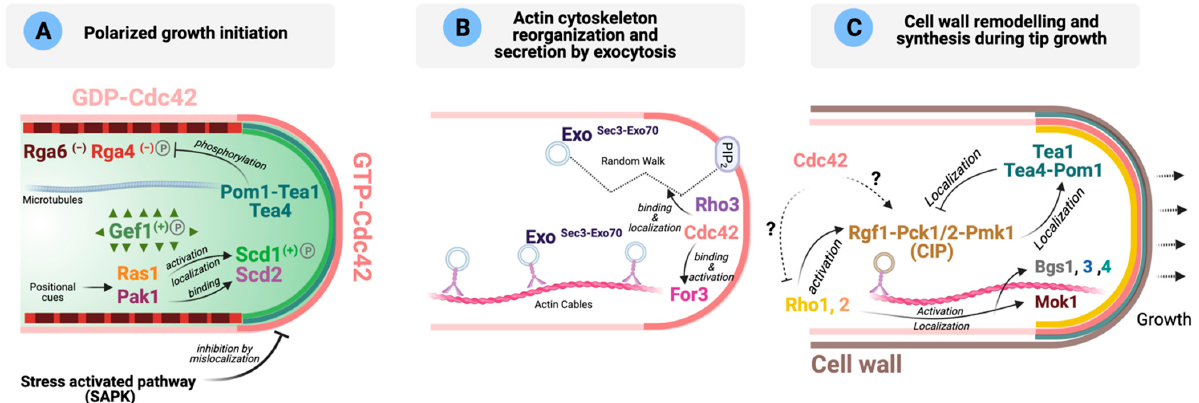
Figure 2. Role of Rho GTPases during S. pombe polarized growth (adapted from [77,146,147]). ( A ) Schematic representation of the main molecular players involved in the local activation of Cdc42 (GTP-Cdc42, dark pink) during polarized growth initiation. GAPs are shown in different shades of red, and GEFs in different shades of green. ( − ): negative regulation on Cdc42; (+): positive regulation on Cdc42; P: protein is phosphorylated. Please see text for details. ( B ) Activated Cdc42 binds and activates formin For3 promoting actin cytoskeleton reorganization. Exocytic vesicles can reach the cell tips either transported along actin cables by myosin V Myo52 or by random walk. Once there, Sec3 and Exo70 tether the exocyst and the vesicle by binding PIP 2 , Cdc42 and Rho3. Exo represents Sec5, Sec6, Sec8, Sec10, Sec15 and Exo84. ( C ) Cell wall remodeling is initiated after secretory vesicles containing the enzymes necessary for cell wall remodeling reach the poles. These enzymes are activated by GTP-Rho1 and -Rho2. The Cell Integrity MAPK Pathway (CIP) is involved in the regulation of cell wall homeostasis, and the polarity landmarks Tea1, Tea4 and Pom1 functionally interact. Dotted arrows mean that the molecular links have not been established. Please see main text for more details.